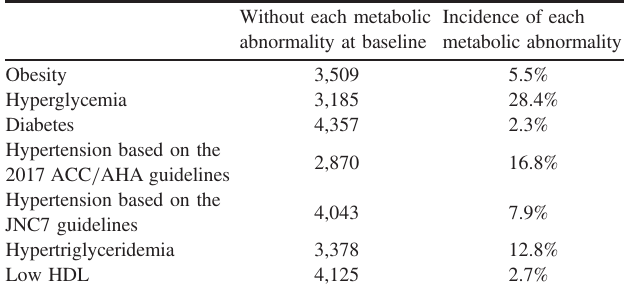
Table 4. Incidence of each metabolic abnormality